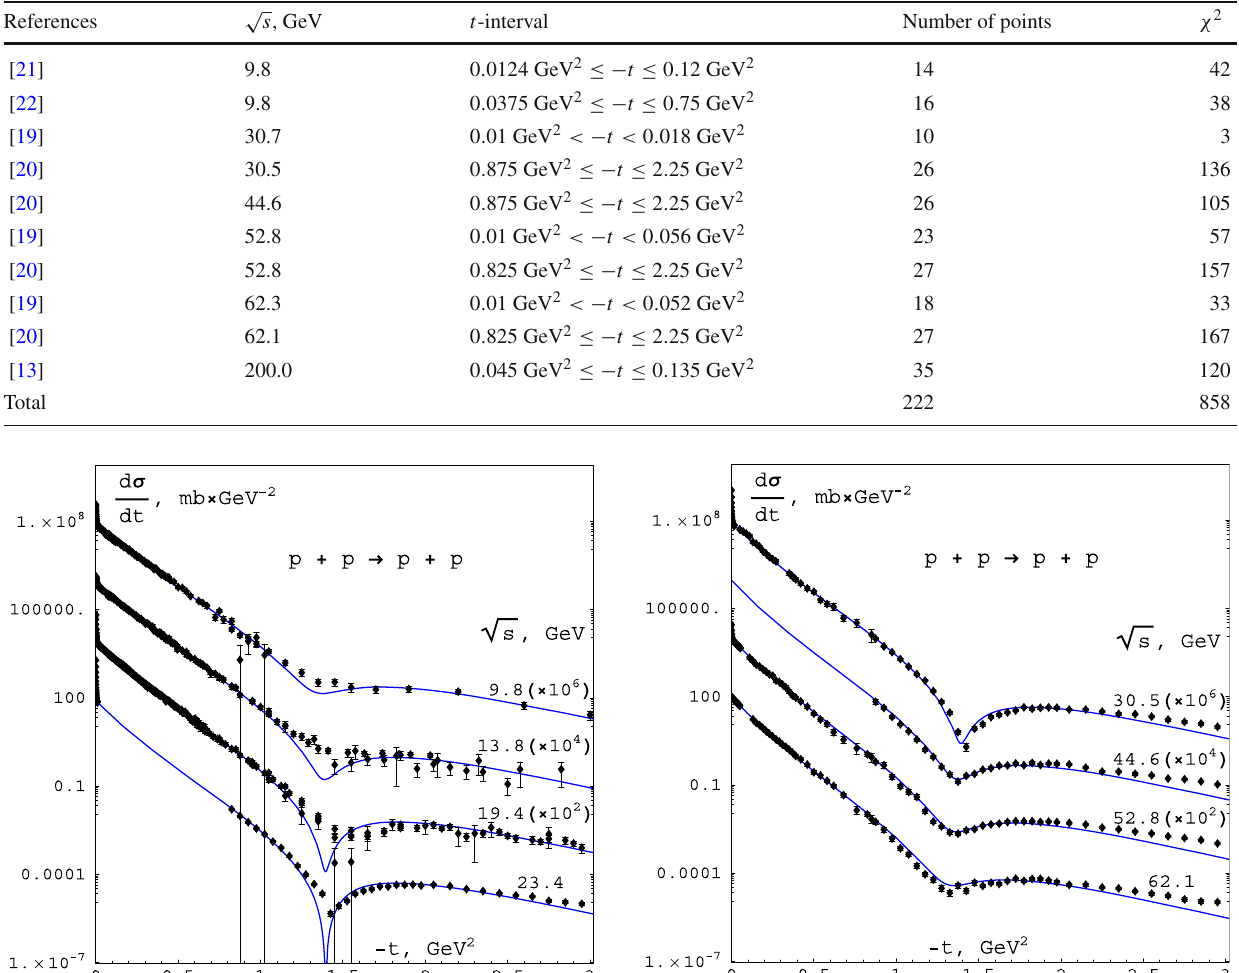
Table 2 The quality of the model description of the proton–proton EDS angular distributions